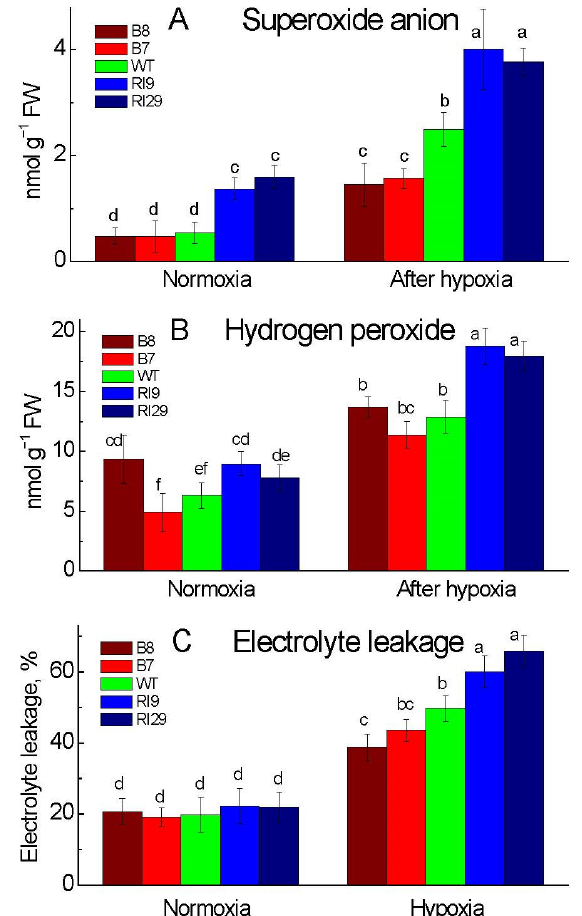
Figure 2. Leaf superoxide anion level ( A ), hydrogen peroxide amount ( B ), and electrolyte leakage rate ( C ) in tobacco plants with differing amounts of alternative oxidase and exposed to normoxia or 6 h hypoxia. The plant lines used included wild type (WT), two alternative oxidase overexpressors (B7 and B8), and two alternative oxidase knockdowns (RI9 and RI29). Vertical bars indicate SD from three to four independent experiments ( n = 3–4); different letters indicate significant differences between five tobacco lines and the treatments.